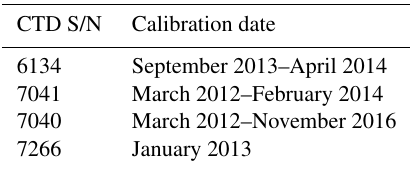
Table 2. Calibration date of the CTD probes named with the serial number